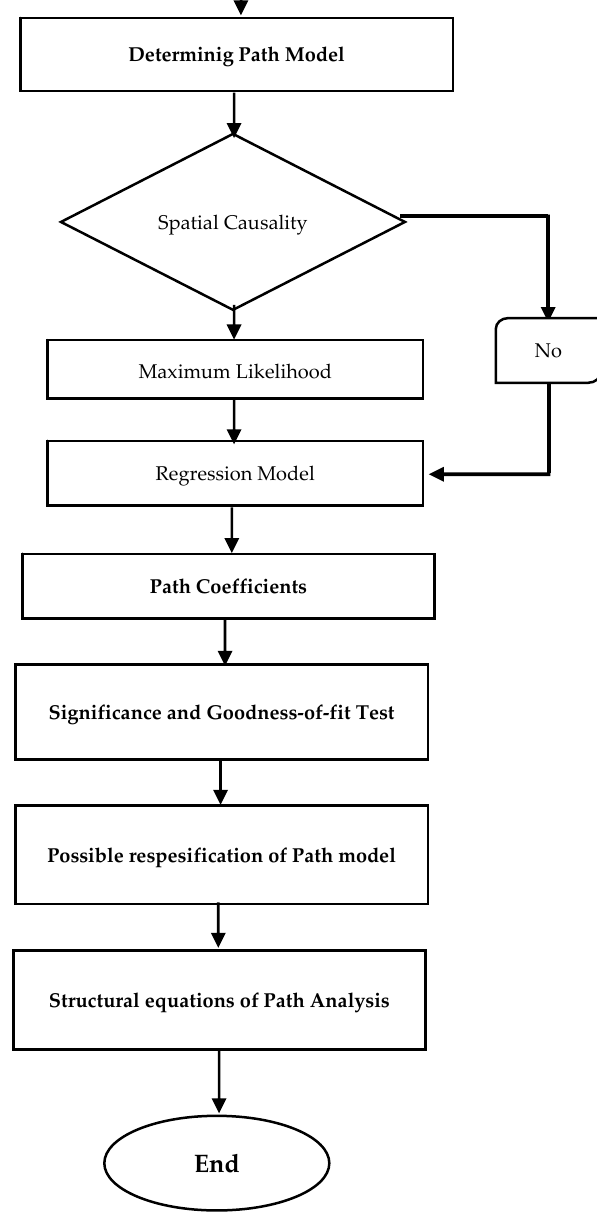
Figure 1. The stages of spatial path analysis.